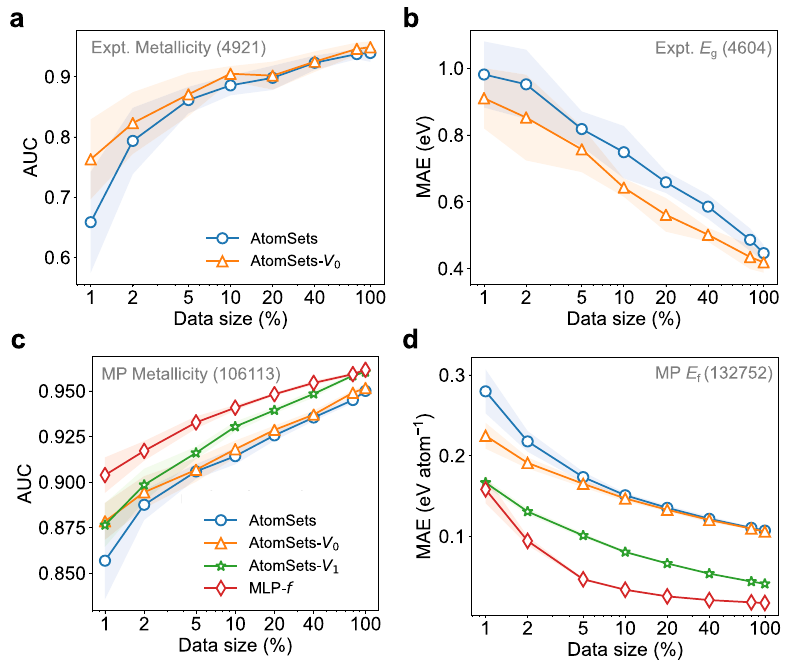
Fig. 2 Model convergence for AtomSets, AtomSets- V 0 , AtomSets- V 1 and MLP- f . a and b show the small compositional datasets, and c and d are for the large structural datasets. a and c show the area under the curve (AUC) for classi fi cation tasks, and b and d show the mean- absolute error (MAE) for regression tasks. The x -axis is plotted on a log scale to provide improved resolution at small data sizes. The shaded areas are the standard deviation across fi ve random data fi tting. Additional model results are shown in Supplementary Fig.